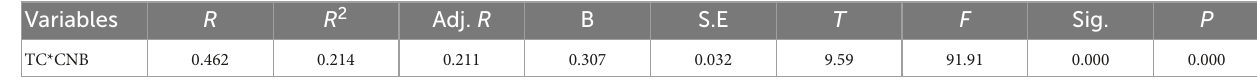
TABLE 1 Linear regression results.